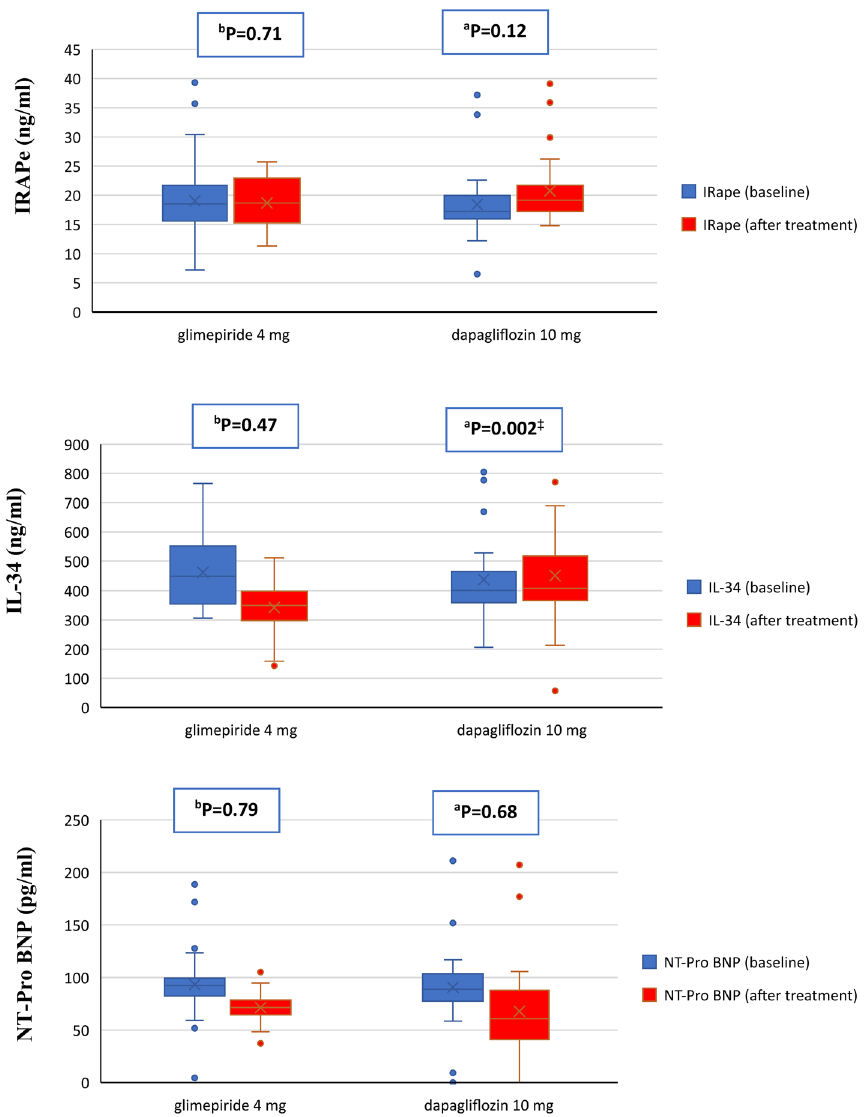
Independent sample t-test, b P: baseline; a P: after treatment.